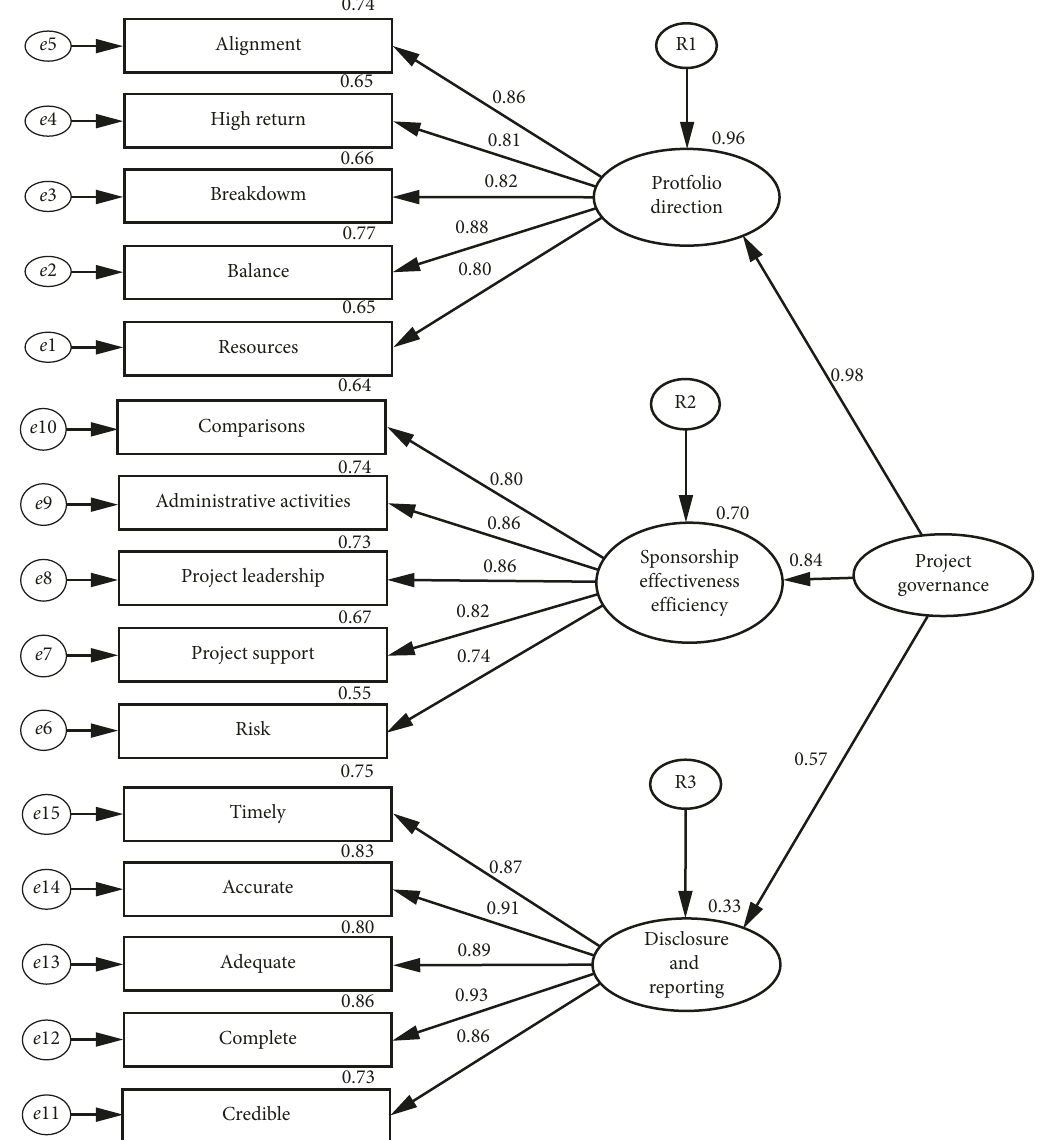
Figure 1: Second-order CFA for PG.